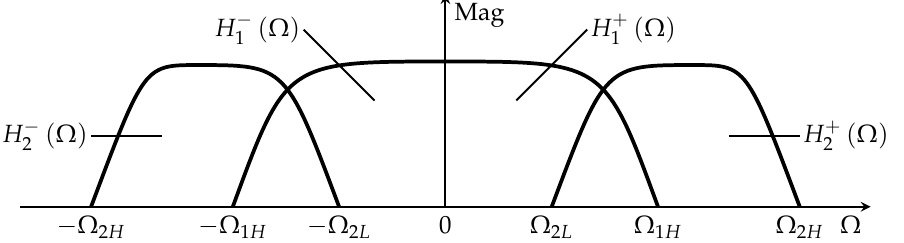
Figure 2. Frequency response of input diplexer. H 1 ( Ω ) is the low-pass channel, H 2 ( Ω ) is the high- pass